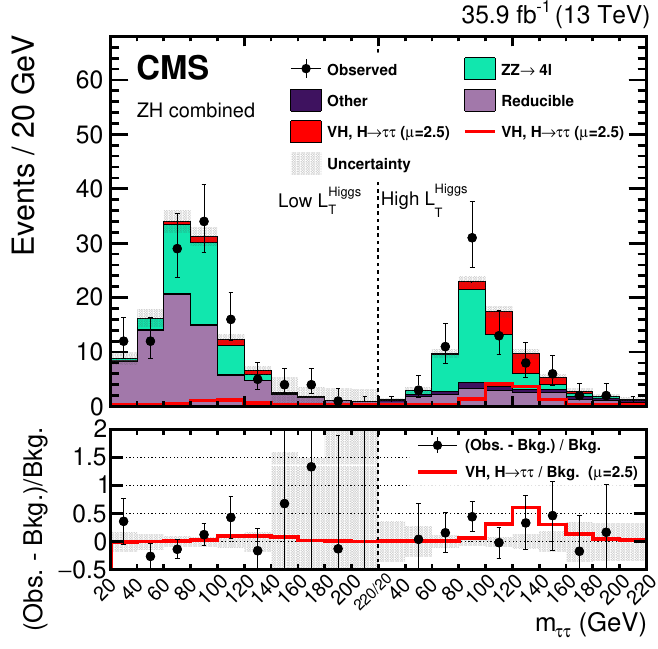
Figure 2 . The post-(cid:12)t m (cid:28)(cid:28) distributions used to extract the signal, shown for all 8 ZH channels combined. The uncertainties include both statistical and systematic components. The left half of the distribution is the low L Higgs region, while the right half corresponds to the high L Higgs T The de(cid:12)nitions of the L Higgs regions in this distribution are the same as those used in (cid:12)gure 1 and T